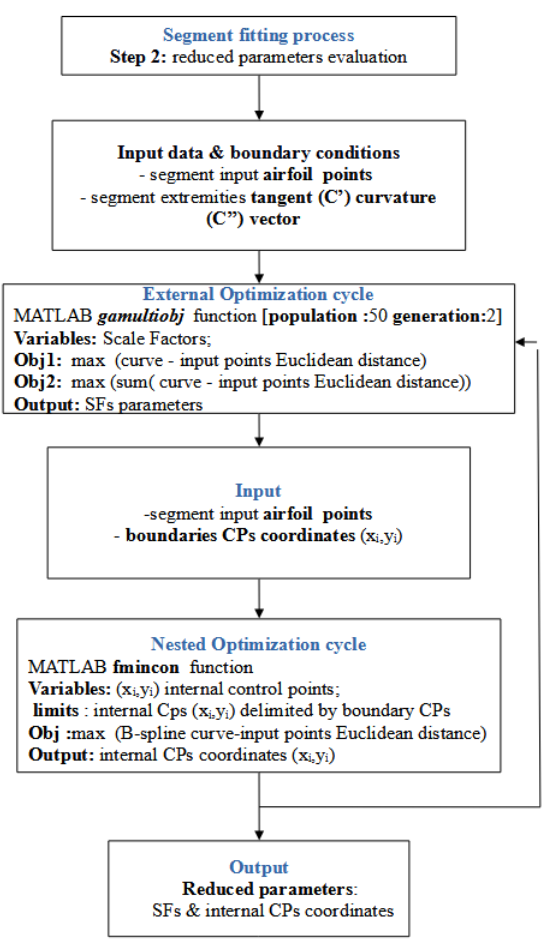
Figure 12. Segment fitting process, step2 flowchart. Algorithms 2–4 are the segment fitting process step 2 pseudocodes and the setting of MATLAB external gamultiobj, nested fmincon algorithms.